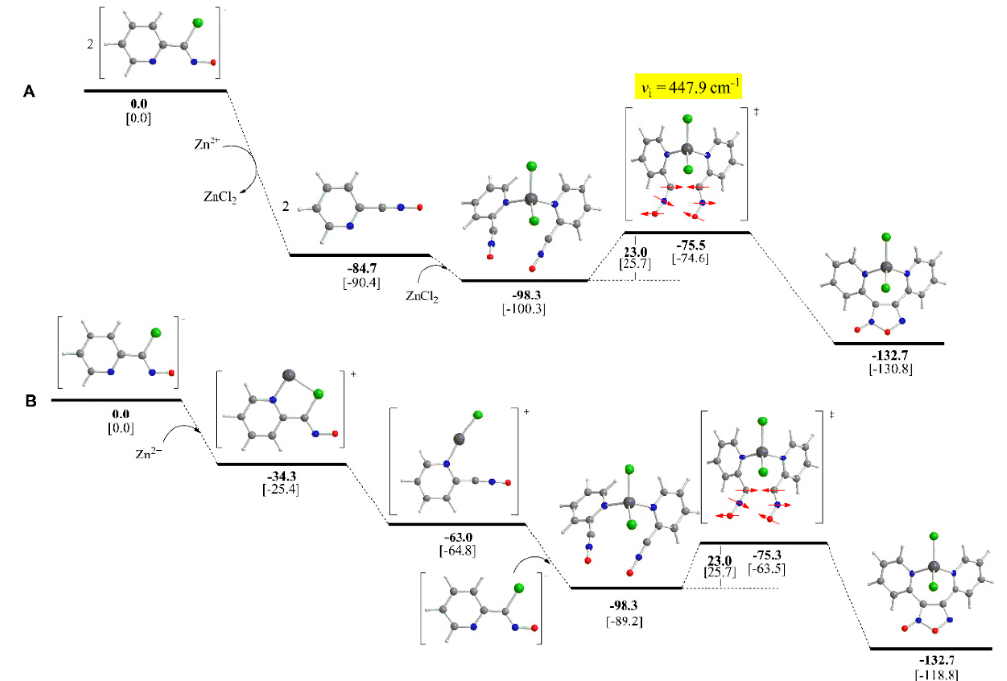
Figure 8. Geometric and energetic ( ∆ H in Kcal / mol, bold numbers / ∆ G in Kcal / mol, plain numbers in brackets) reaction profile for the cross-coupling reaction between the coordinated pao ligands promoted by the [ZnCl 2 (pao) 2 ] complex at the PBE0 / Def2-TZVP(Cr) ∪ 6-31G(d,p)(E) / PCM level of theory in solution (MeOH).